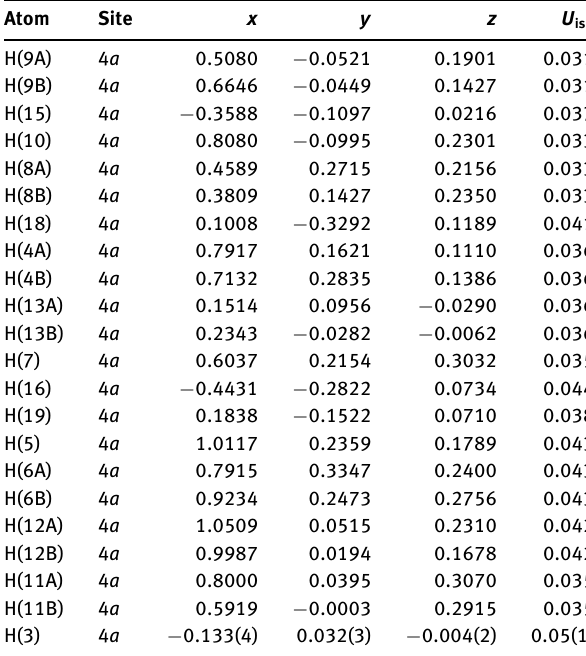
Table 2: Fractional atomic coordinates and isotropic or equivalent isotropic displacement parameters (Å 2